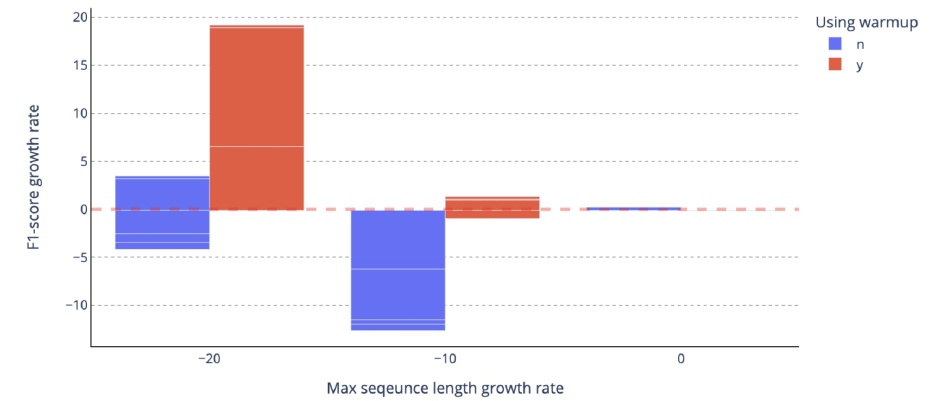
Figure 6. F1-score’s increase and decrease rate according to maximum token length decrease rate. − 20 means an experiment in which the maximum token length decreased by more than 10% and less than 20%, and − 10 means an experiment in which the maximum token length decreased by more than 0%, and less than 10% represents summation. Pink dotted line: the value when there is no change in